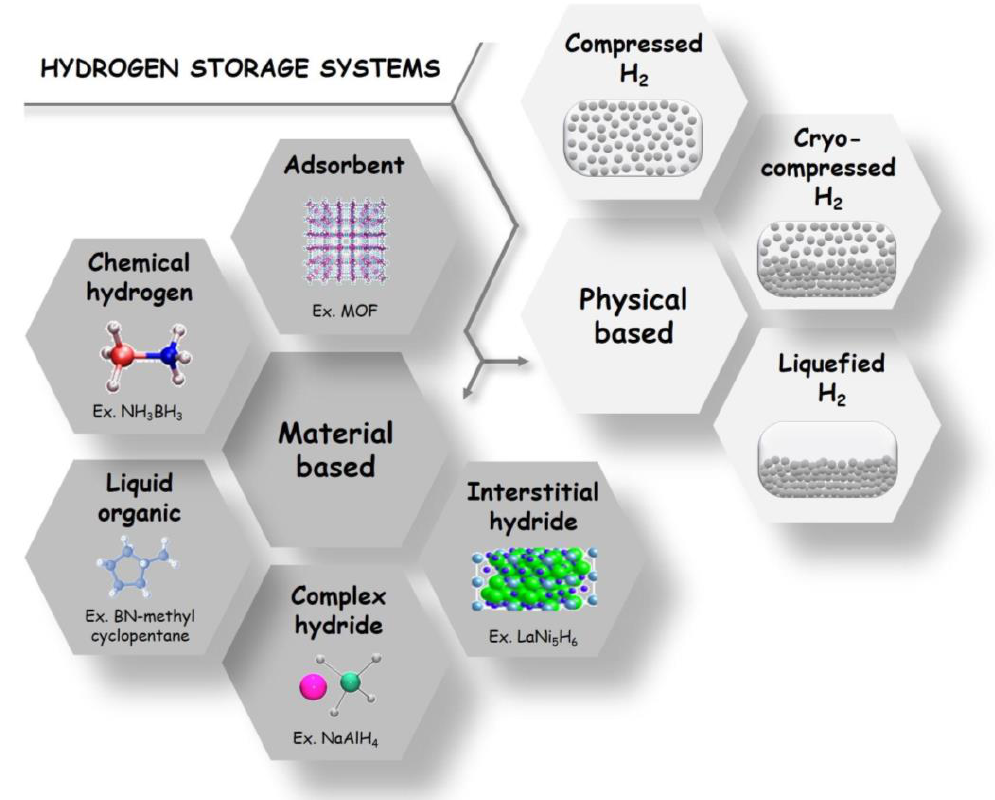
Figure 2. Schematization of hydrogen storage technologies.